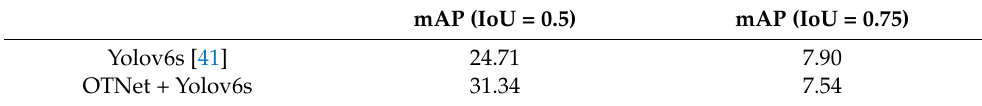
Table 6. The performance of yolov6 with/without